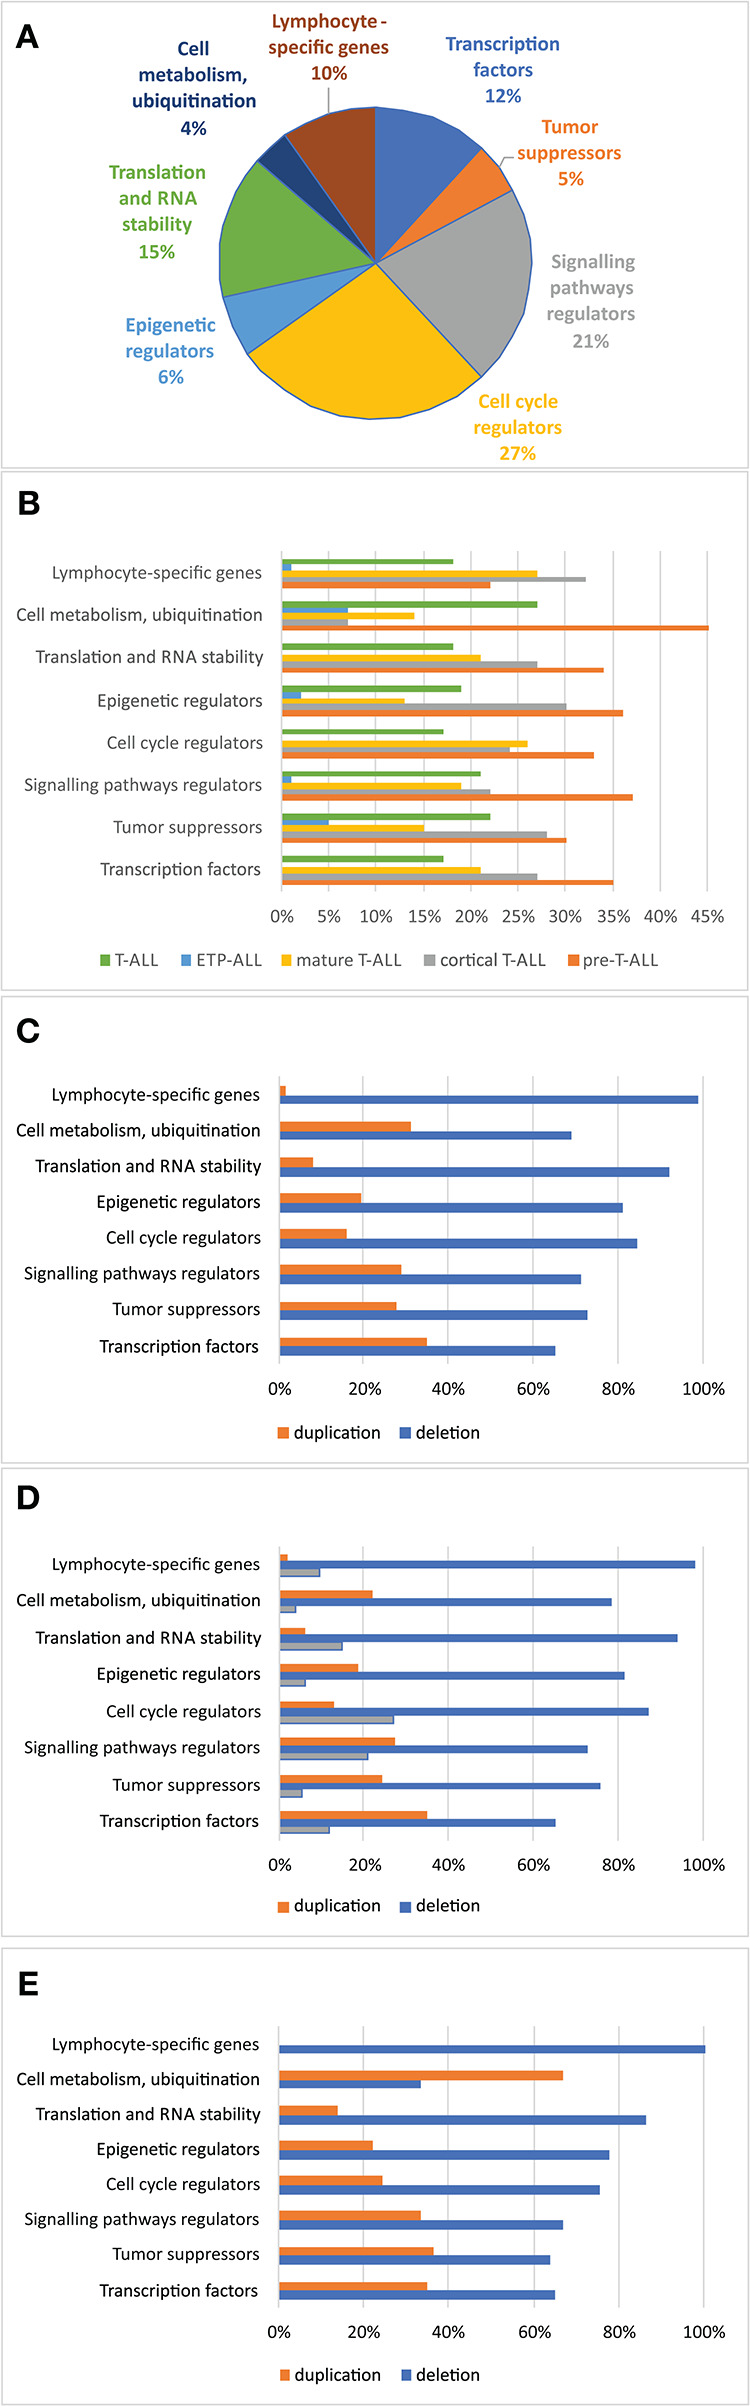
Frequency of copy number alterations identified in 86 T-ALL cases. The incidence of CNAs relative to specific groups of genes (A). Percentages of CNAs relative to specific groups of genes (B). Percentages of CNAs relative to specific group of genes in the group of boys (C), girls (D), and all cases (E).